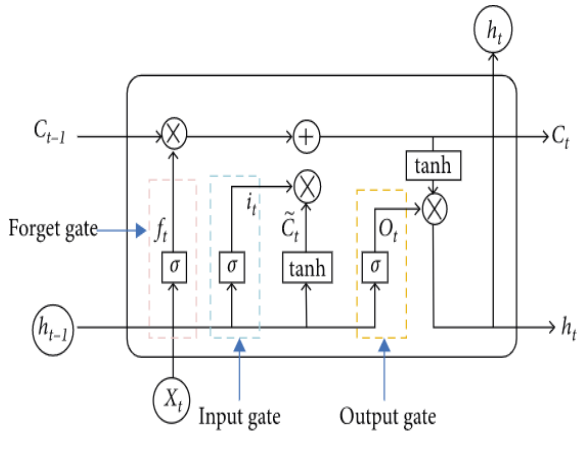
Figure 2. Long Short term Memory (LSTM) [14]